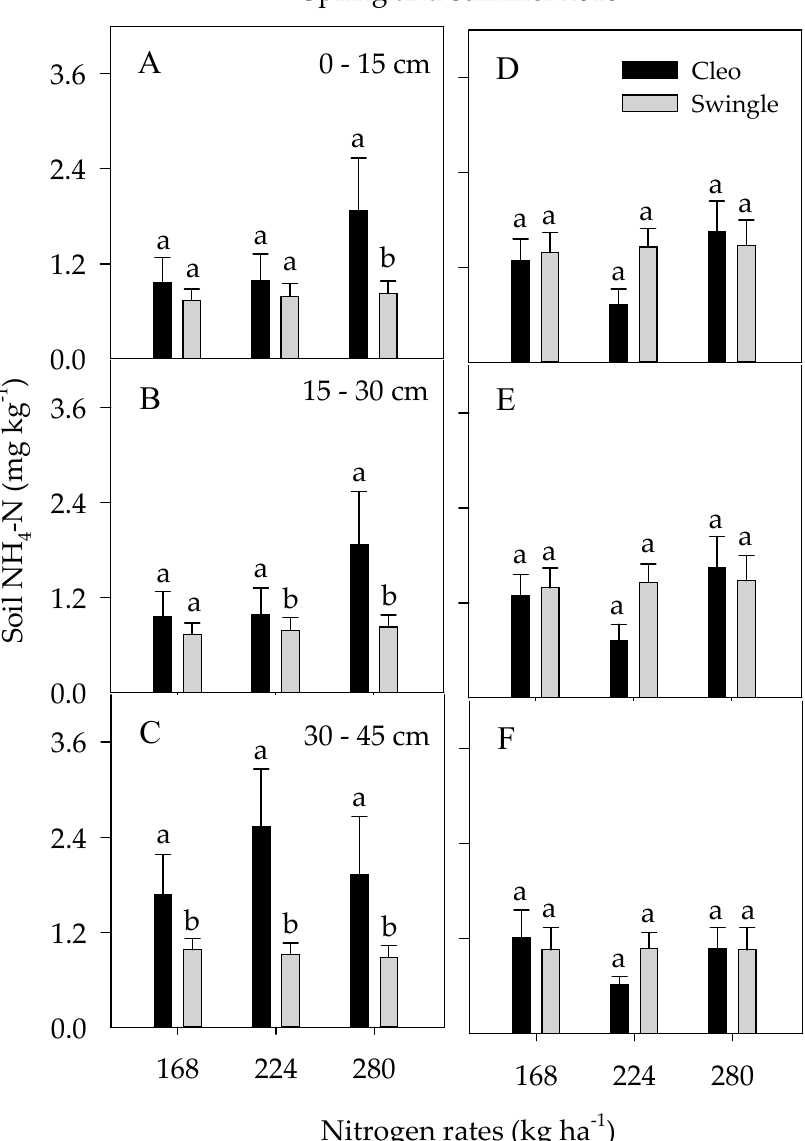
Figure 6. Soil NH4-N dynamics and accumulation of Huanglongbing (HLB)-affected Hamlin citrus trees budded on Cleo and Swc rootstocks during spring ( A – C ) and summer ( D – F ) 2018 in three soil depths (0–15, 15–30, and 30–45 cm). Means with different lower case letters are significantly different at p ≤ 0.05, based on the Tukey–Kramer honestly significant difference test (n = 36).